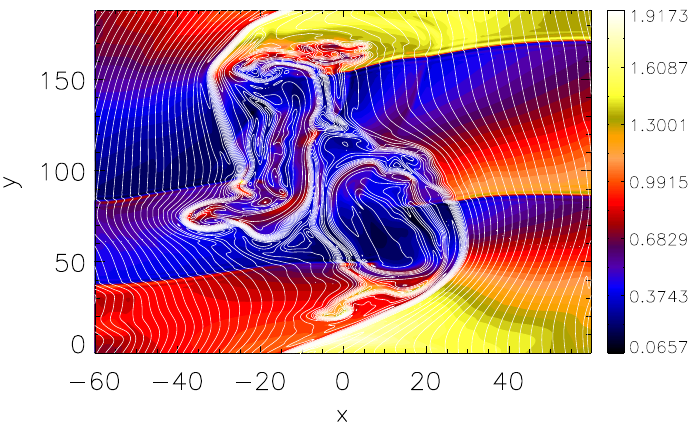
Figure 10. Isocontour of pressure P = P e + P i in the ( x , y ) -plane for the case V 0 = 4.6 and ∆ n = 0.7 at t = 360 s. The pairing of vortices that pass through the shocks is shown. Overplotted it is shown the magnetic field in the plane with the magnetic island originated from the reconnection process in the vortices.